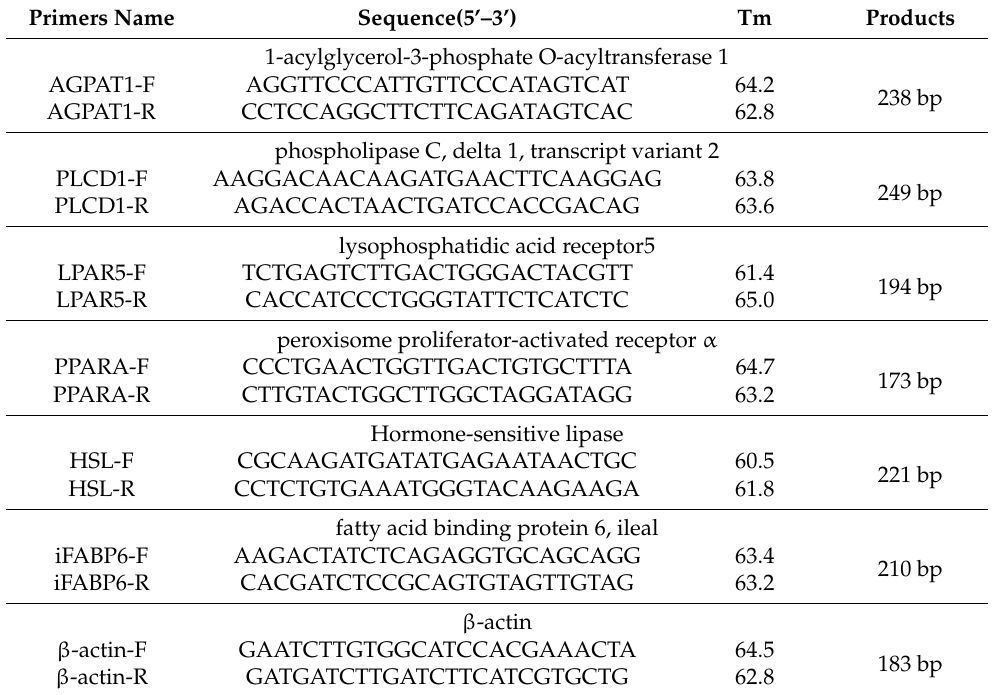
Table 2. RT-qPCR primers for the verified